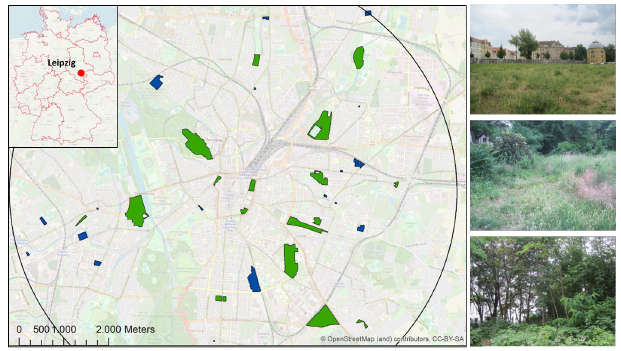
Fig. 1 . Study sites in the city of Leipzig. We selected 18 urban parks (green) and 18 brownfields (blue) in a 5 km radius from the city center. Photos on the right show examples of green brownfields in Leipzig with varying tree cover. More photos of brownfields and urban parks can be found in Appendix 1 (Figures A1.1-A1.6). Map source: OpenStreetMap and contributors; Photos: J.